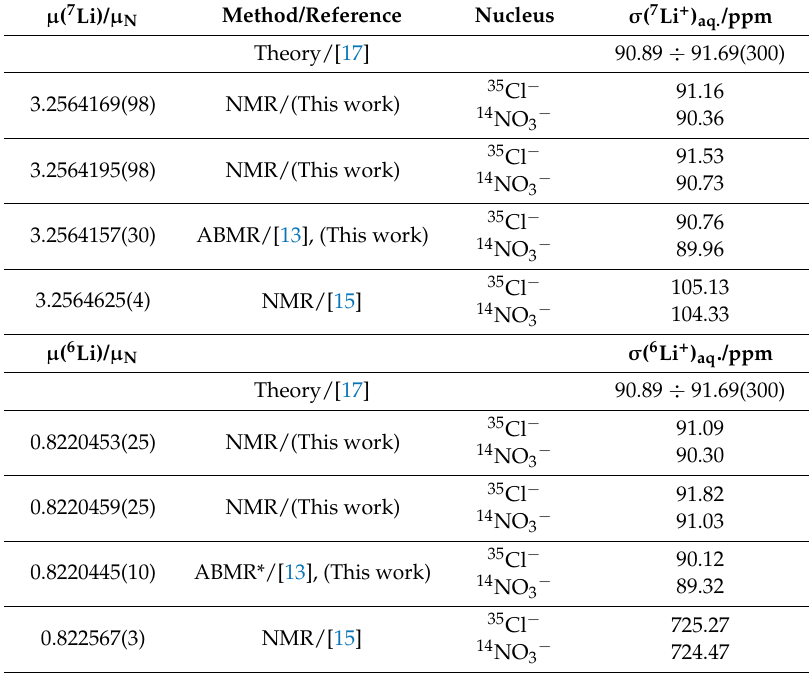
Table 2. 6/7 Li nuclear magnetic shielding values calculated from Equation (3) and selected nuclear magnetic moments. Theoretical results for hexa- and tetra-coordinated water